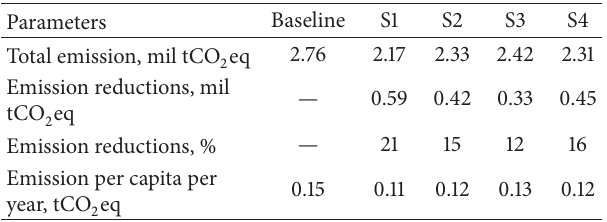
Table 5: Total GHG emissions from 103